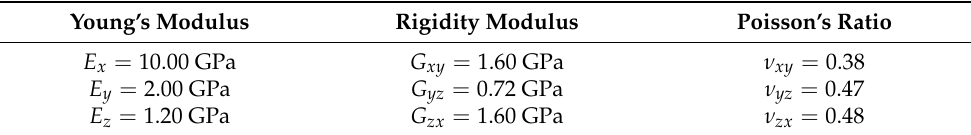
Table 1. Mechanical parameter values of the simulated material, taken from [9]. Density ρ is assumed to be equal to 700 kg/m 3